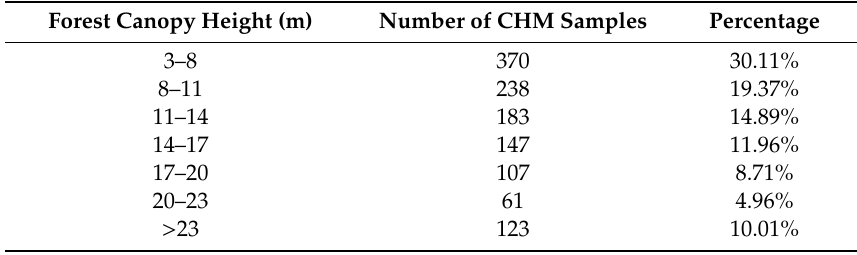
Table 4. Statistical table of forest canopy height in discontinuous CHM